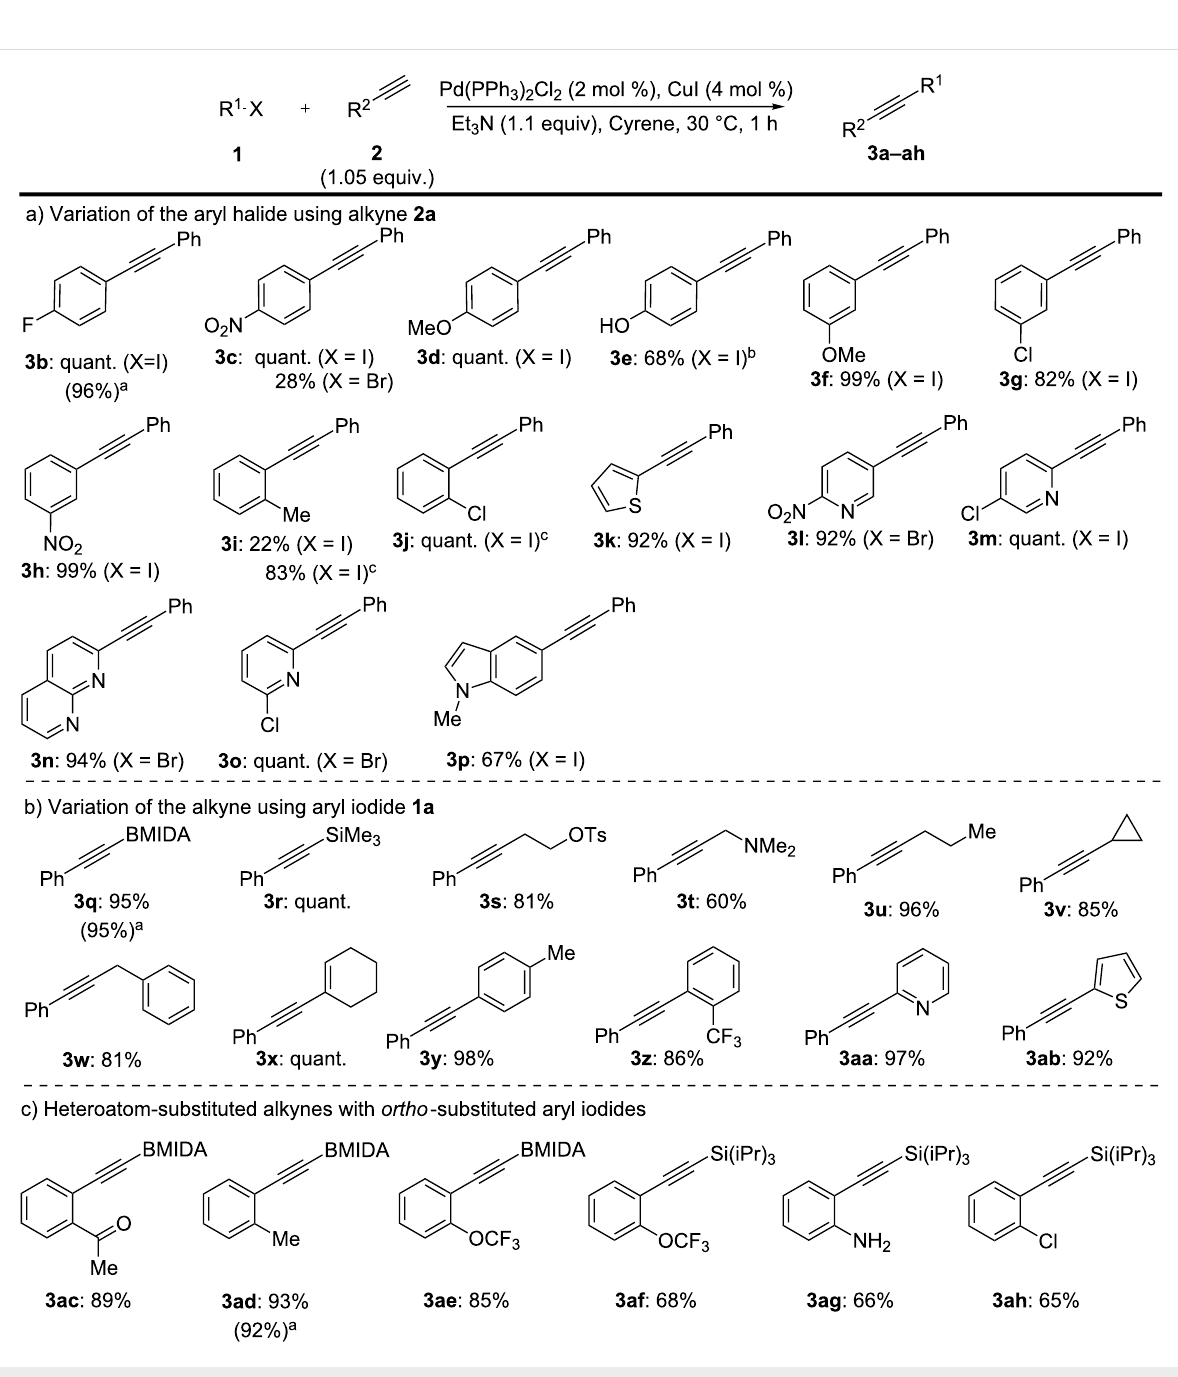
[42,43]. Specifically, employing ortho -amino ( 5 ) or ortho - hydroxyaryl iodides ( 6 ) in the Sonogashira process generated an alkyne intermediate that, upon increasing the reaction tempera- ture from 30 °C to 60 °C, could undergo 5- endo -dig